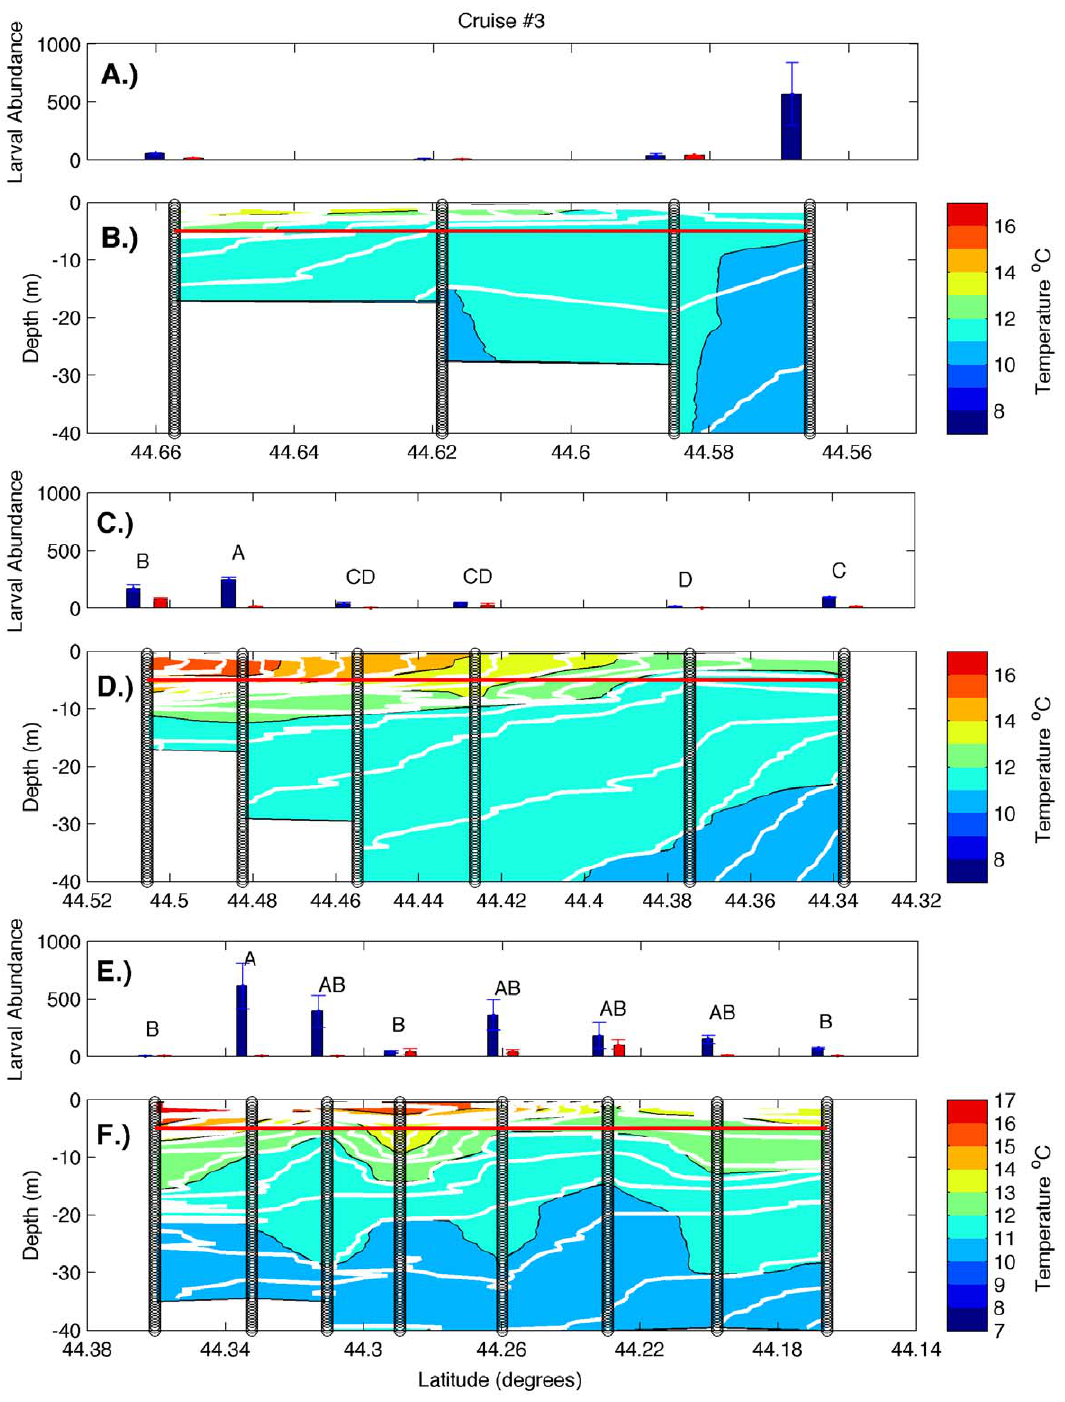
Figure 4. Larval abundance and water column structure on August 3–6, 2010. Panels represent larval abundance and water column structure, respectively, for transects 1 (A, B), 2 (C, D), and 3 (E, F). Larval abundance is presented as larvae m 2 3 at 5 m (blue bars) and 0.25 m (red bars). Error bars represent one standard error. The red line indicates the depth at which 5 m samples were collected. Variation in larval density among stations was significant on transects 2 and 3 (one-way ANOVA, p , 0.0001 and p , 0.01, respectively), and letters indicate 5 m stations that did not differ significantly from one another (Tukey-Kramer post-hoc test, p . 0.05). Vertical black lines represent the locations of CTD and larval sampling stations, color gradations represent water temperatures, and the white contour lines represent